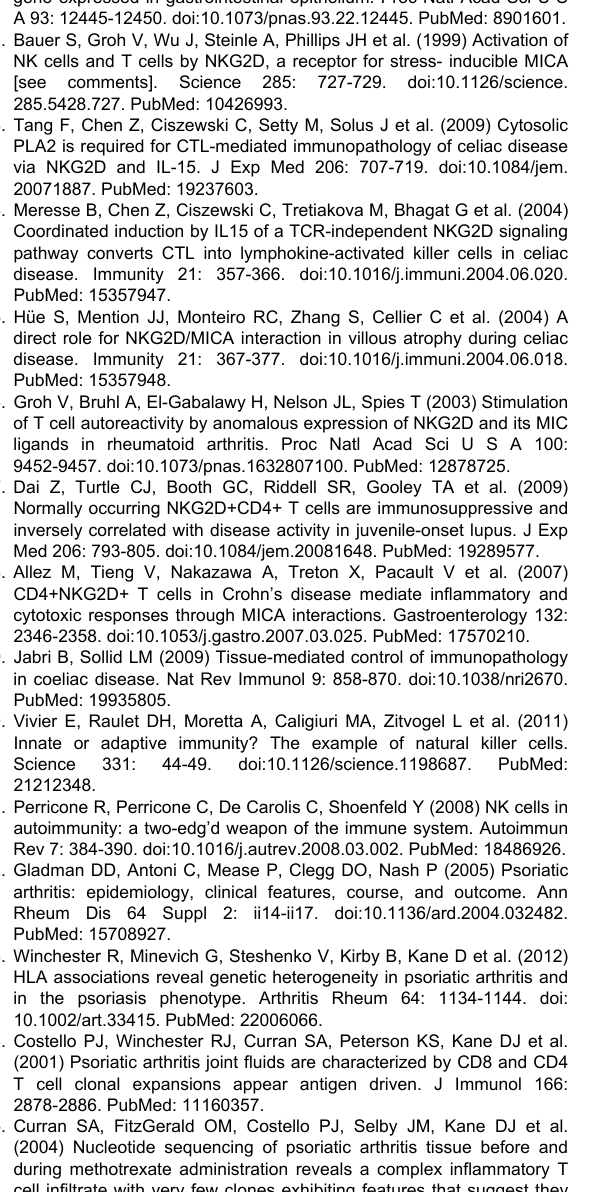
targets at comparable levels to joint fluid lymphocytes. Data are representative of three independent